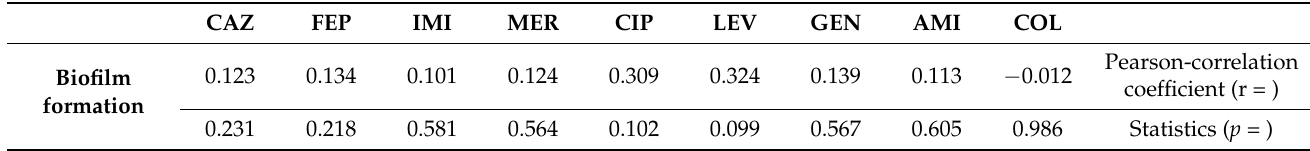
Table 3. Correlation matrix regarding the microbial categories (weak/moderate/strong) based on biofilm formation and resistance to antibiotics in P. aeruginosa isolates.